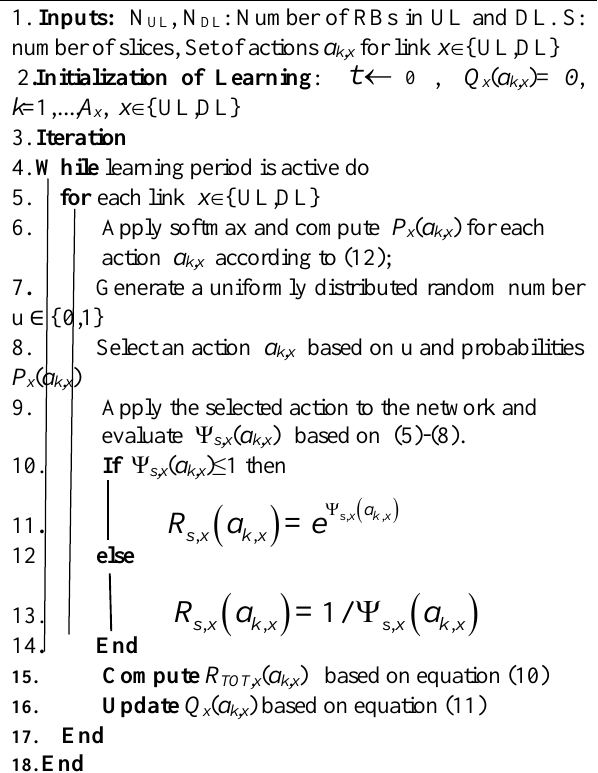
Algorithm 1 : RAN slicing algorithm based on